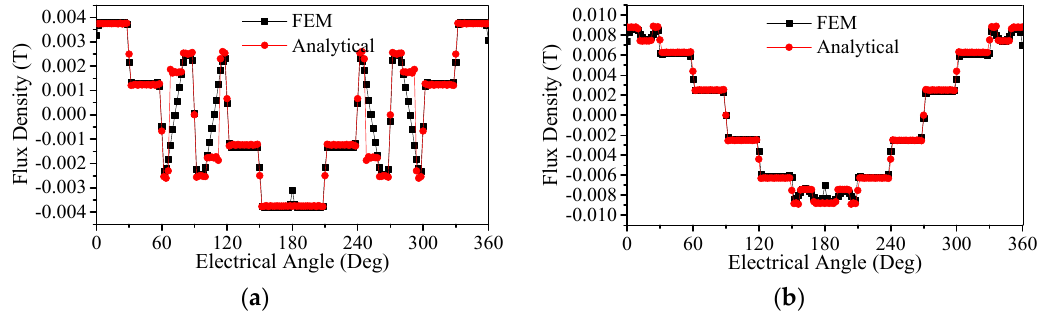
Figure 11. Comparison of airgap flux density: ( a ) in the d ‐ axis; ( b ) in the q ‐ axis. Table 3. The inductances of the two methods.